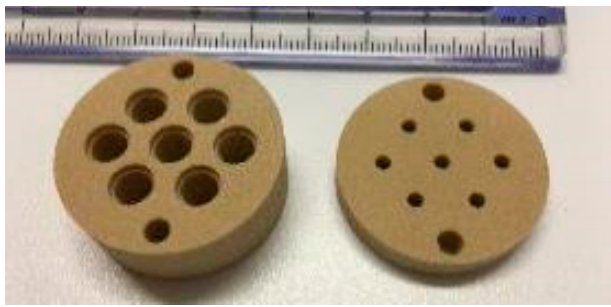
Figure 5. Lens side of the seven-lens sensor head ( left ), and POF side of sensor head ( right ).